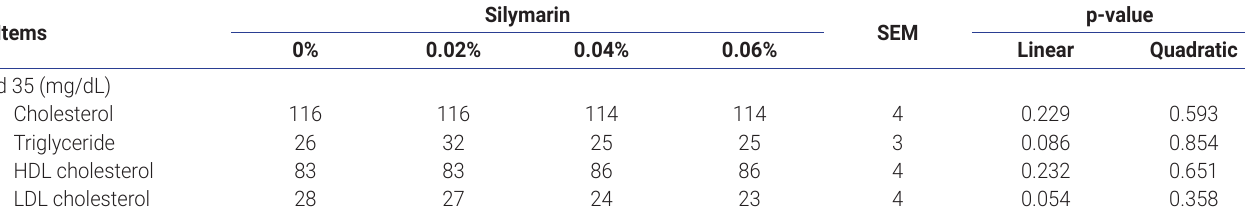
Table 6. The effect of Silymarin supplementation on the blood profile of broilers